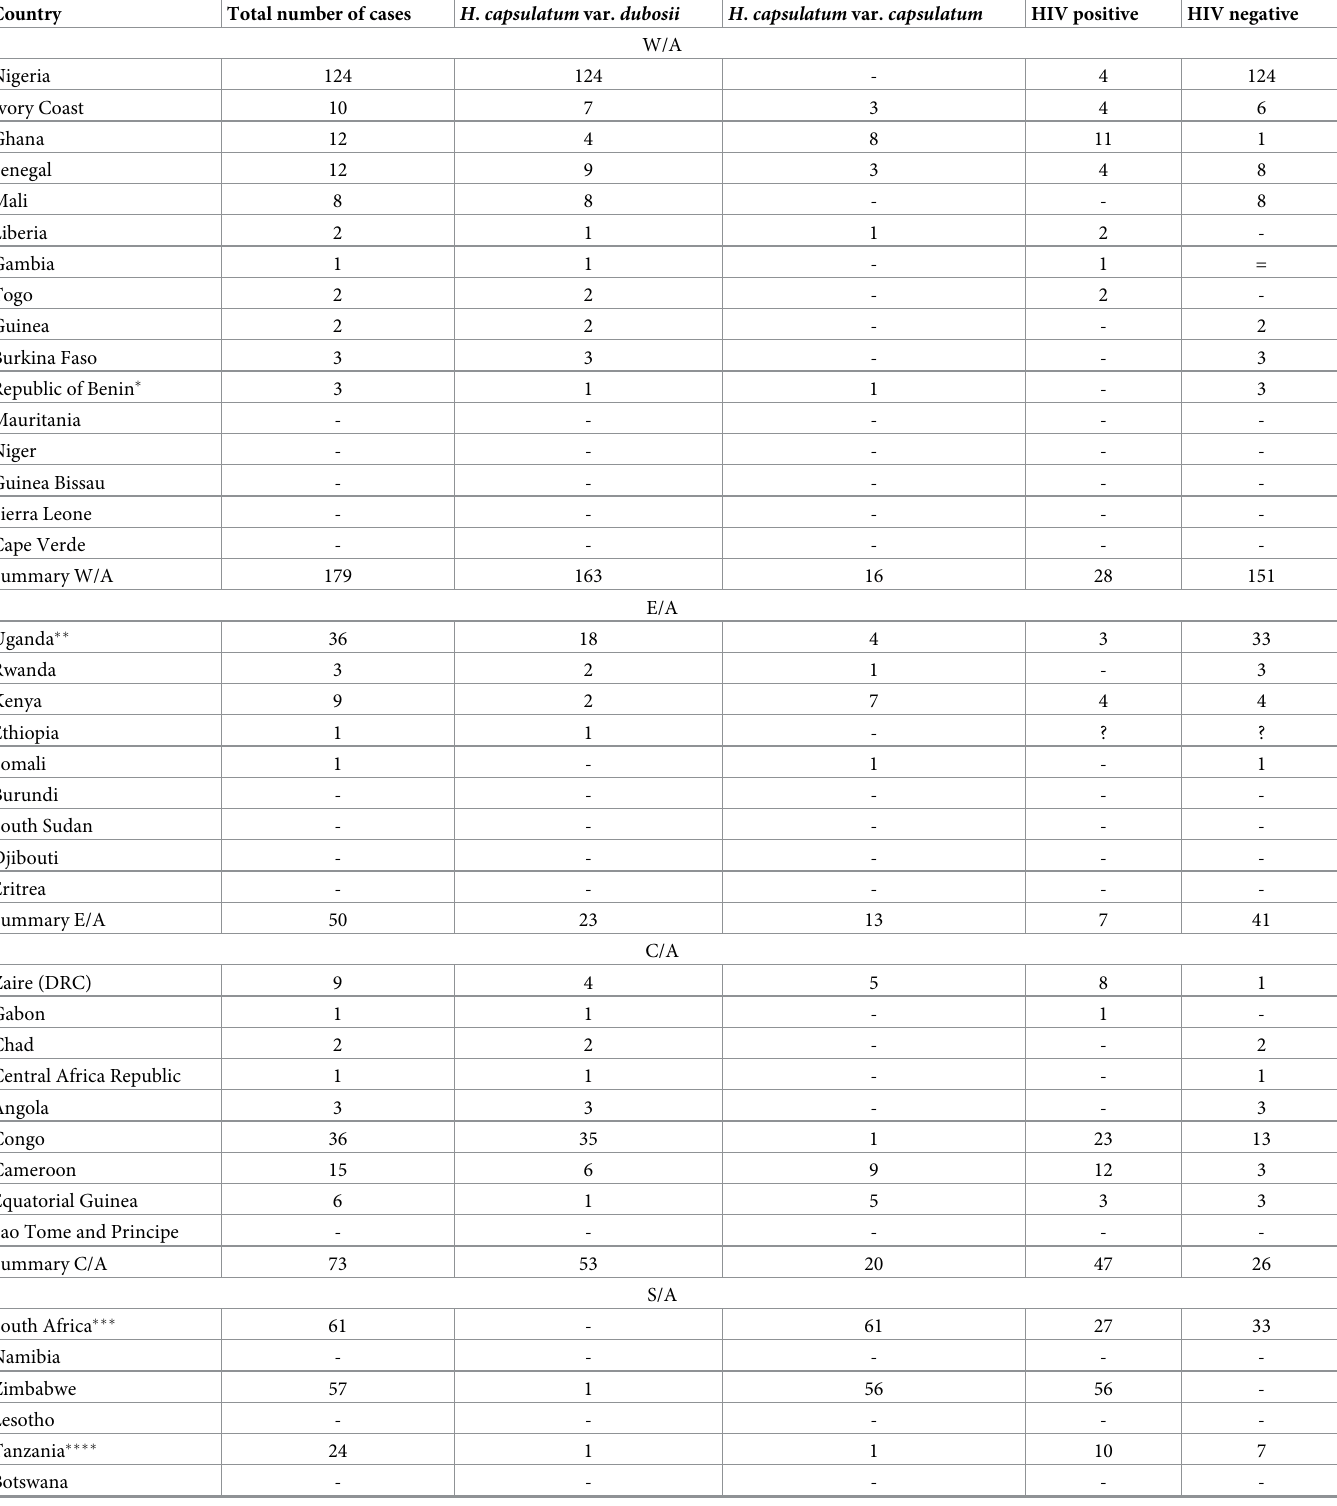
Table 1. Distribution of histoplasmosis in Africa.